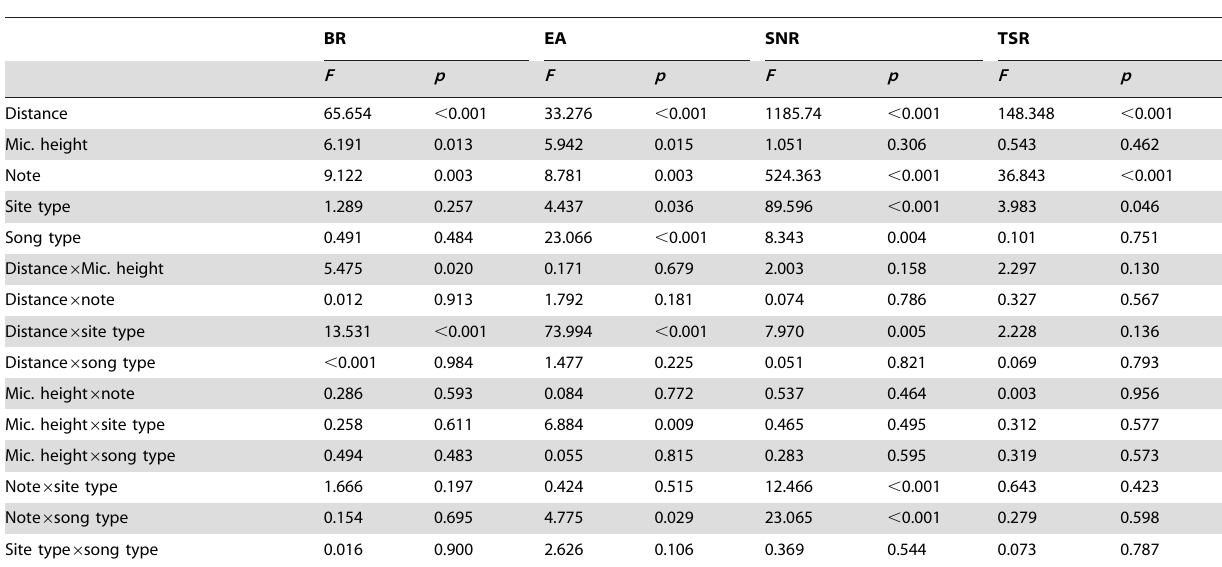
Table 2. Factorial ANOVA table of experiment 2 showing the main effects and two-way interactions of all the variables on the four measurements of